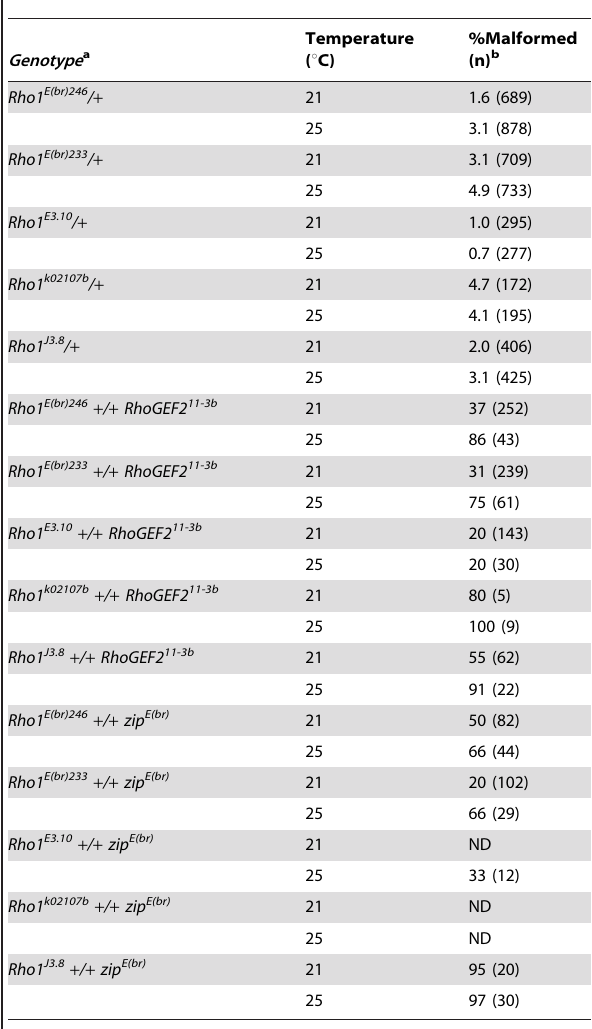
a Balanced, Rho heterozygous mutant virgin females were crossed to either w 1118 males, or males bearing RhoGEF2 or zip mutations over a second chromosome balancer at 21 u C and 25 u C. b % malformed indicates the percentage of animals of the indicated genotype showing a malformed leg phenotype in at least one leg. n , total number of flies of the indicated genotype that were scored. ND, not